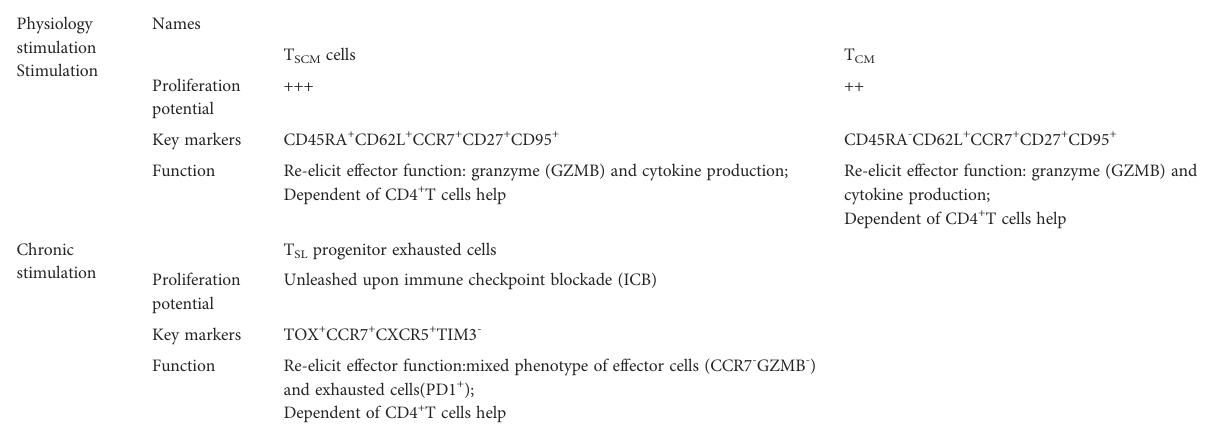
TABLE 1 Comparison between T SCM ,T CM and stem-like progenitor T EX cells (60, 65).